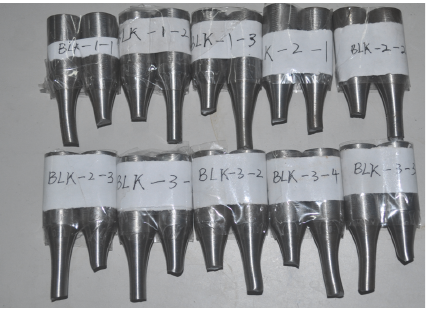
Figure 12: Ruptured specimens.